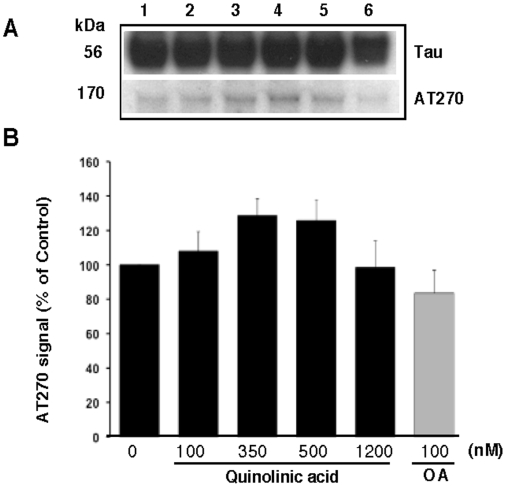
QA treatment induced the aggregation of tau:A: Representative blot showing the presence of a high molecular weight (∼165 kDa) band recognized by the PHF-specific antibody AT270 in response to QA treatment. Treatments are the same as shown in Figure 4. B: Quantitative estimation of the high molecular weight tau band normalized for total tau. The data presented are the average (±SD) of four experiments from four different brains and are expressed as the ratio of signal for AT270 to that of signal for total tau.